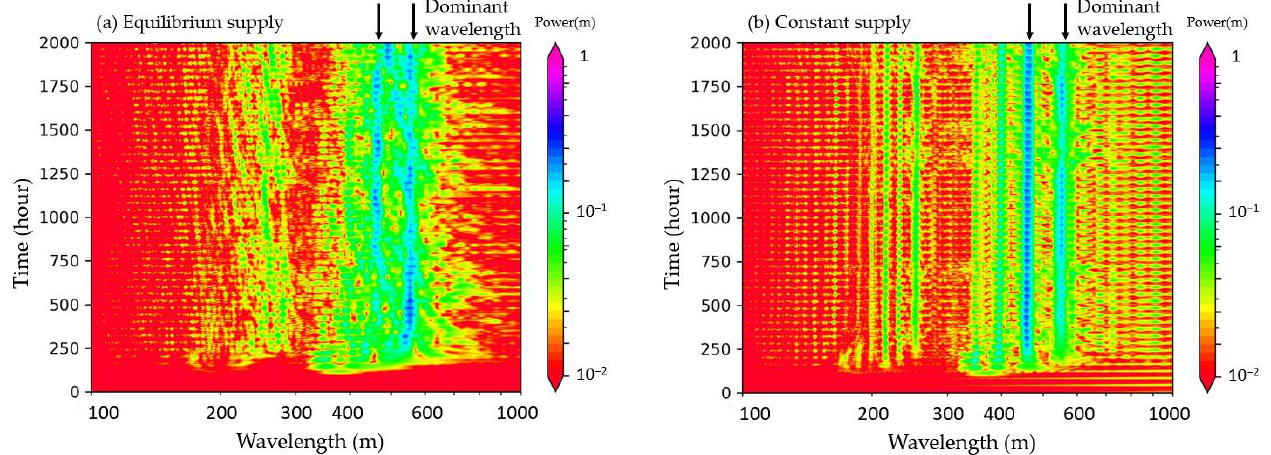
Figure 12. FFT analysis of dominant wavelength in Case 2. ( a ) Equilibrium sediment supply. ( b ) Constant sediment sup- ply.